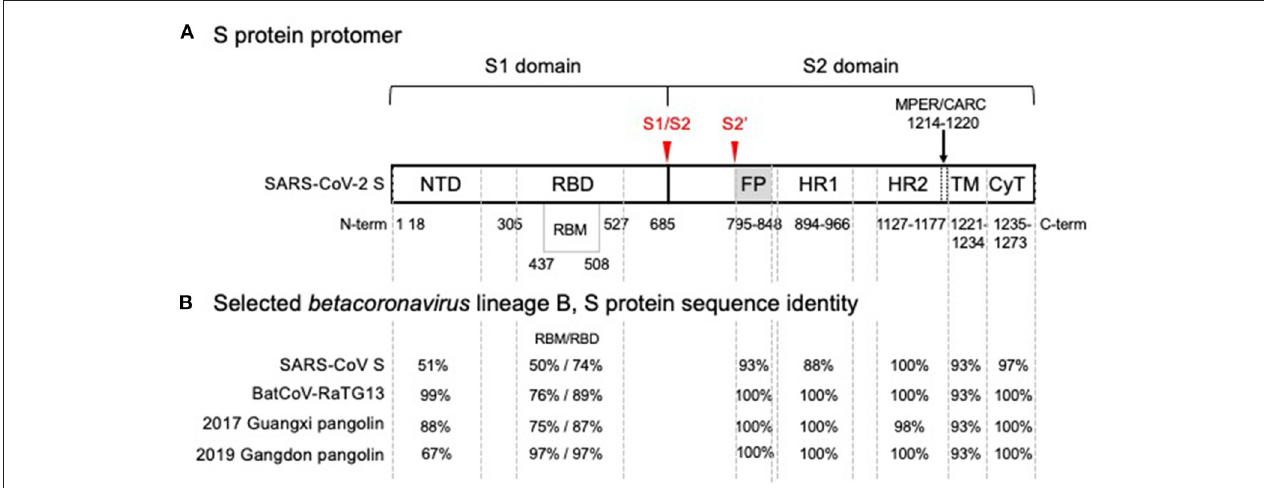
FIGURE 1 | SARS-CoV-2 spike glycoprotein monomer representation showing (A) functional domains and (B) comparison of amino acid sequence identity with SARS-CoV and related isolates in the wild. (A) Functional domain S1 mediates binding of the receptor binding domain (RBD) to the angiotensin converting enzyme 2 (ACE2), the host cell receptor that is specifically recognized by the receptor binding motif (RBM) interface, is cleaved (S1/S2) and shed. Shedding exposes the S2 domain. Cleavage at S2’ triggers spike trimer activation, release of the fusion peptide (FP), heptad repeat 1 (HR1) and heptad repeat 2 (HR2); the membrane proximal external region (MPER) is sometimes considered part of HR2 and with a cholesterol recognition/interaction amino acid consensus (CARC) sequence, potentially participating in membrane lipid fusion. The transmembrane domain (TM) and a short cytoplasmic tail (CyT) are indicated. Cleavage sites that drive host-cell infection are shown in red. (B) Phylogenetic analysis of SARS-CoV-2 domain sequences identity among SARS-CoV-2, bat and pangolin’s isolates, and SARS-CoV are tabulated for each domain. A high degree of sequence identity for the RBD in SARS-CoV correlates well with ACE2 receptor recognition. However, the RBM-ACE2 interface is 50% identical and may account for the increased ACE2 binding affinity. Sequence identities are high for all functional segments of S2, the Type I metastable domain that induces viral-host cell membrane fusion, suggesting an optimum sequence-structure-function relationship. Metastability is a functional requirement, allowing these proteins to refold into a lower energy conformation while transferring the difference in energy to catalyze the membrane fusion reaction. Structural studies have shown that stable immunogens presenting the same antigenic sites as the labile wild-type proteins efficiently elicit potent neutralizing antibodies. In the alternative endosomal pathway that is apparently mediated by NTD, the fusion machine of S2 is equally required to infect the host cells (9, 10). Furthermore, detrimental amino acid substitutions found in the S2 domain of Hepatitis Mouse Virus, but not in SARS-CoV-2, affected the post fusion conformational stability, explaining a reported reduction of S-mediated membrane fusion